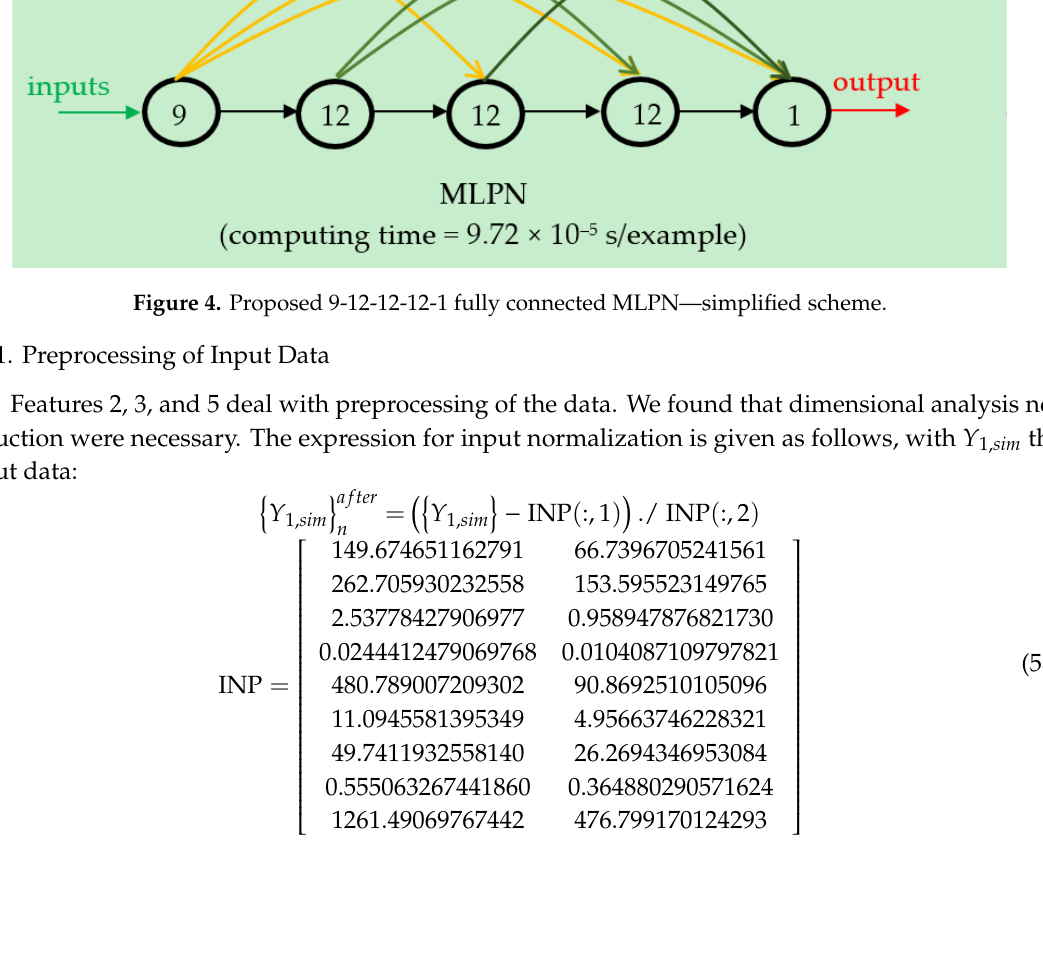
Table 7. For each SA: performance results of best net.